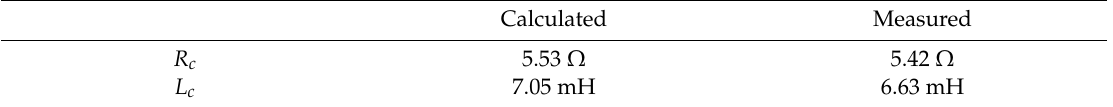
Table 4. Comparison of calculated and measured coil resistance and